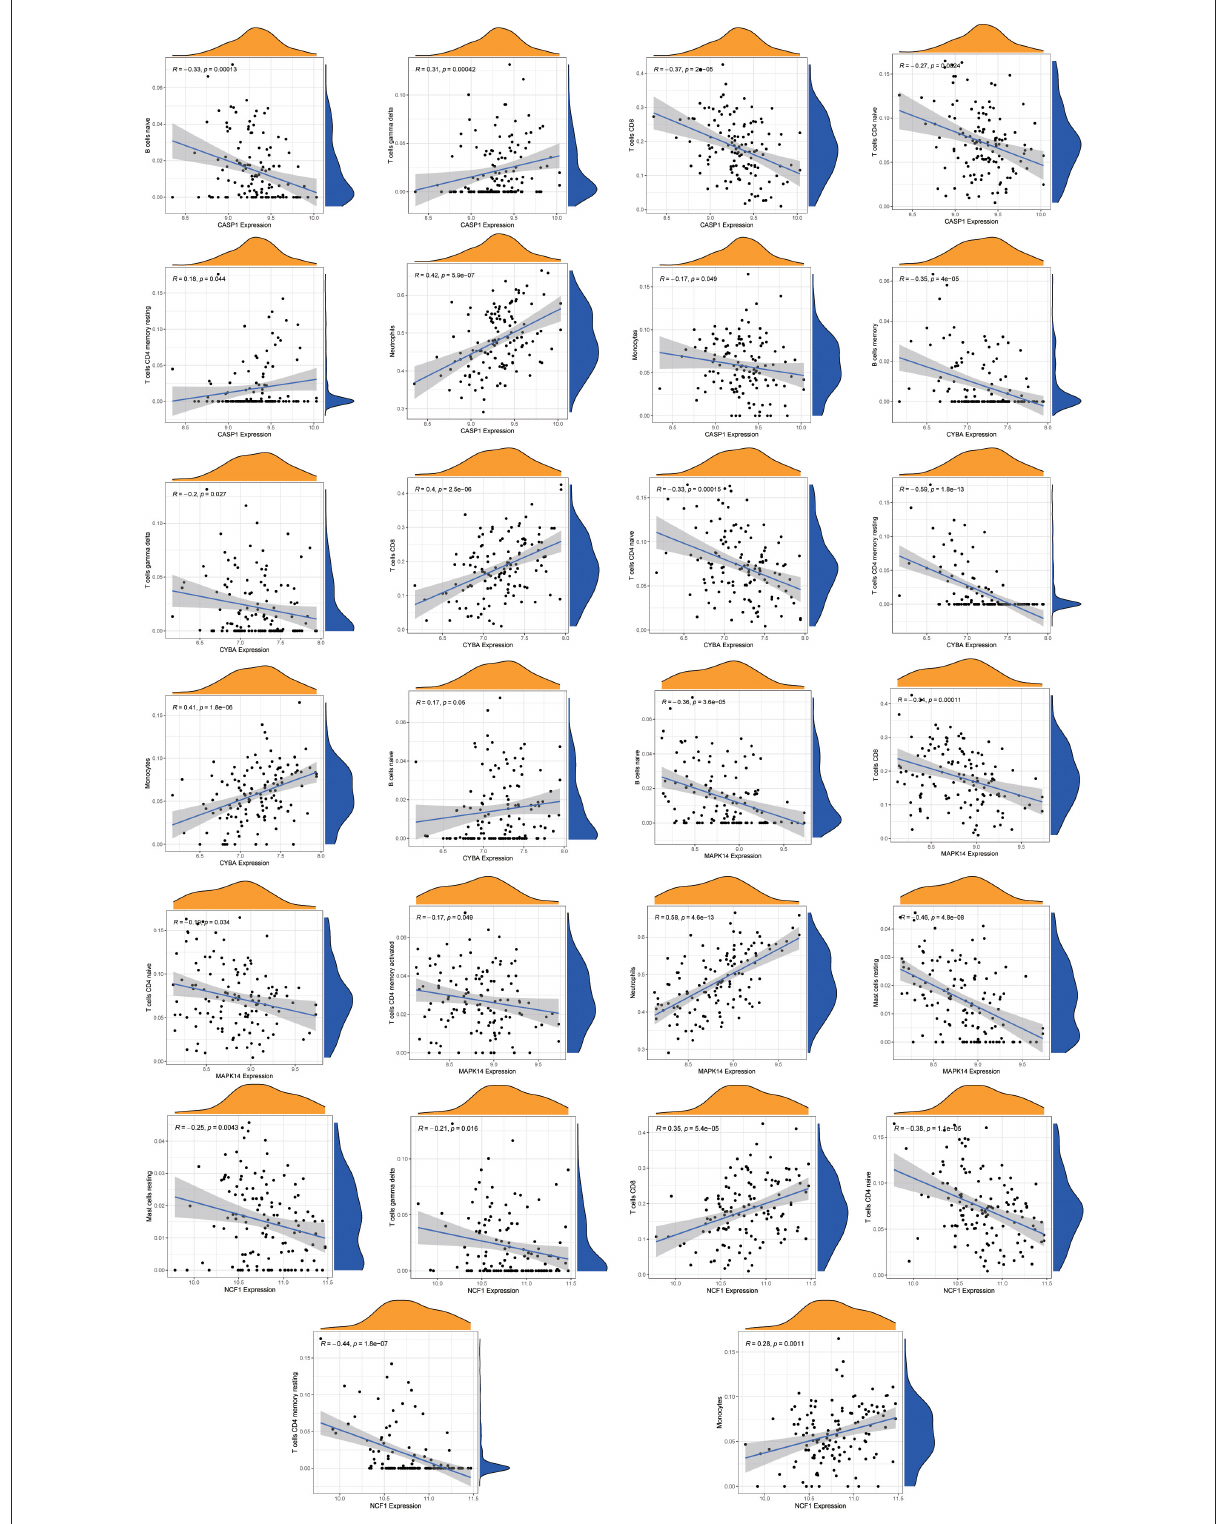
FIGURE12 Correlation analysis of immune cell infiltration and the hub genes. The vertical axis represents the Hub genes expression level, and the horizontal axis represents infiltrated immunocytes expression